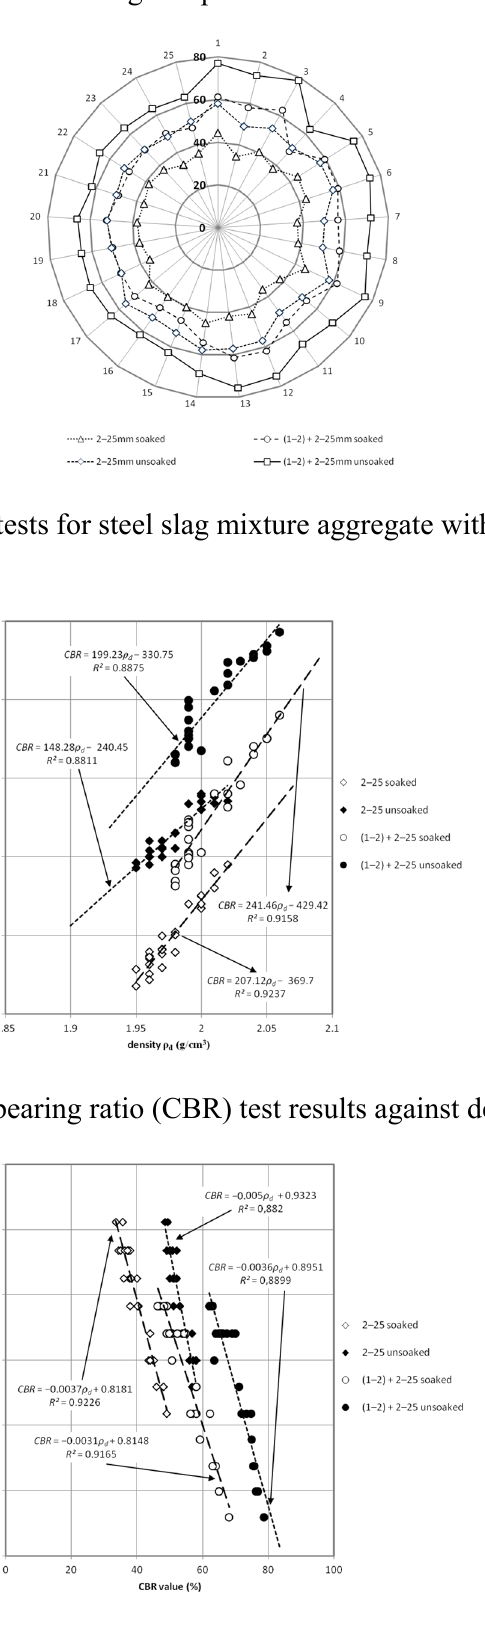
Figure 4. Plot of void ratio diversity for obtained CBR values tested